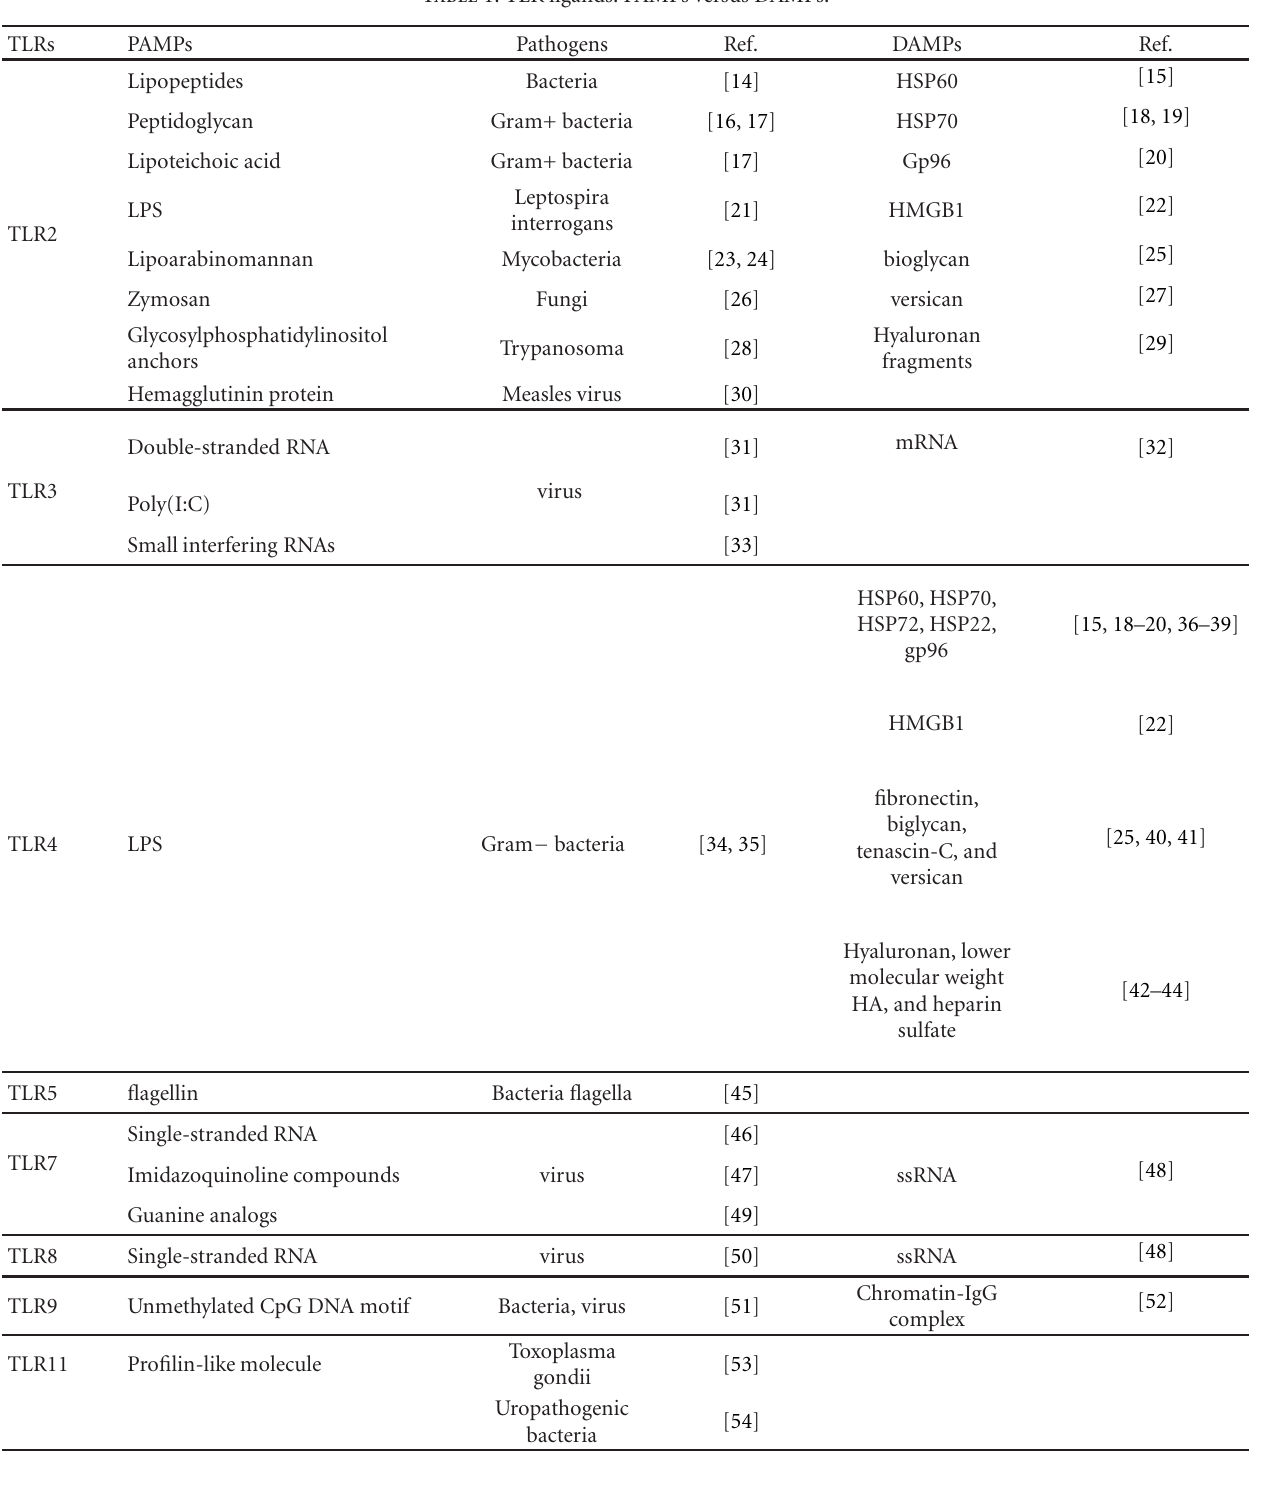
Table 1: TLR ligands: PAMPs versus